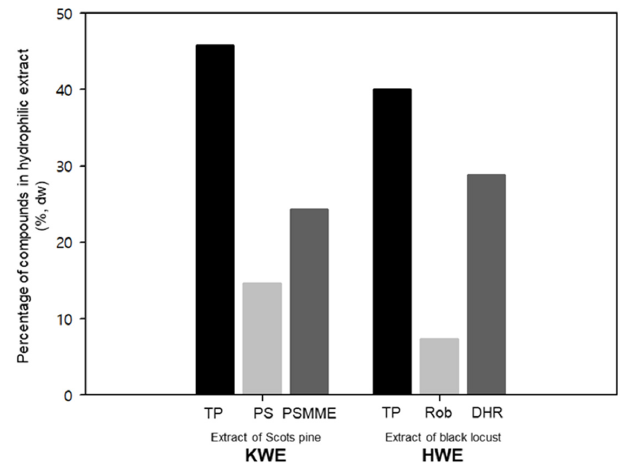
Figure 1. Chemical composition of homogenized extract of Scots pine knotwood (KWE) and homogenized extract of black locust heartwood (HWE). Shares of total phenols (TP), pinosylvin (PS), pinosylvin monomethyl ether (PSMME), robinetin (Rob) and dihydrorobinetin (DHR) in the dried hydrophilic extracts. Forests 2020 , 11 , x FOR PEER REVIEW 10 of 23